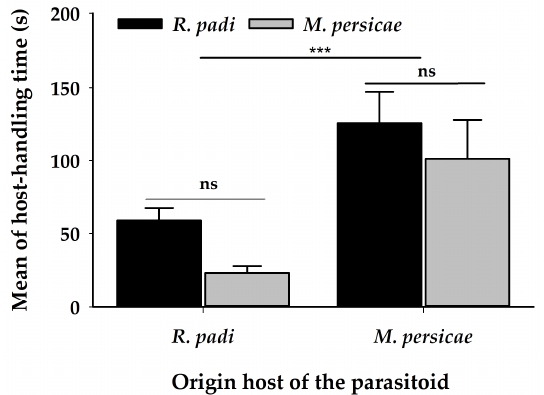
Figure 4. Mean of handling time for oviposition ( ± SE) in seconds of A. platensis from two origins ( R. padi and M. persicae ) exposed to these aphid hosts in a paired arena. Asterisks indicate significant differences: ‘***’ p < 0.001, ‘**’ p < 0.01 ‘*’ p < 0.05, ‘ns’ non-significant p > 0.05. Black and grey bars show the chosen/tested host.